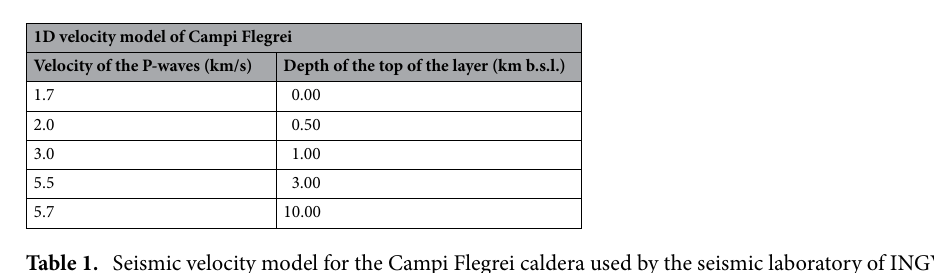
Table 1. Seismic velocity model for the Campi Flegrei caldera used by the seismic laboratory of INGV - Osservatorio Vesuviano, the Vp/Vs is 1.78 ( 4 and reference there in).